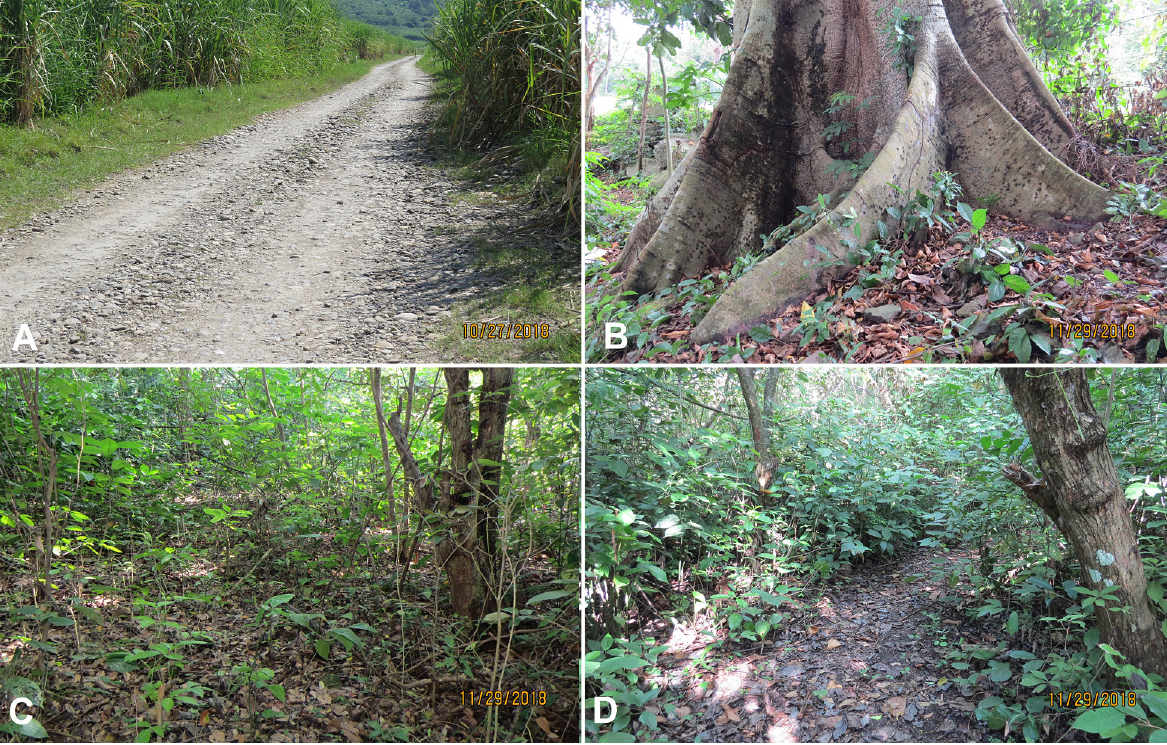
Figure 2. Collecting points for 4 individuals of Loxopholis rugiceps in the Departamento de Cortés, Honduras.. A. Male UCR 23181. B. Female UVS-V-01232. C. Female UVS-V-01233. D. Female UVS-V-01234.